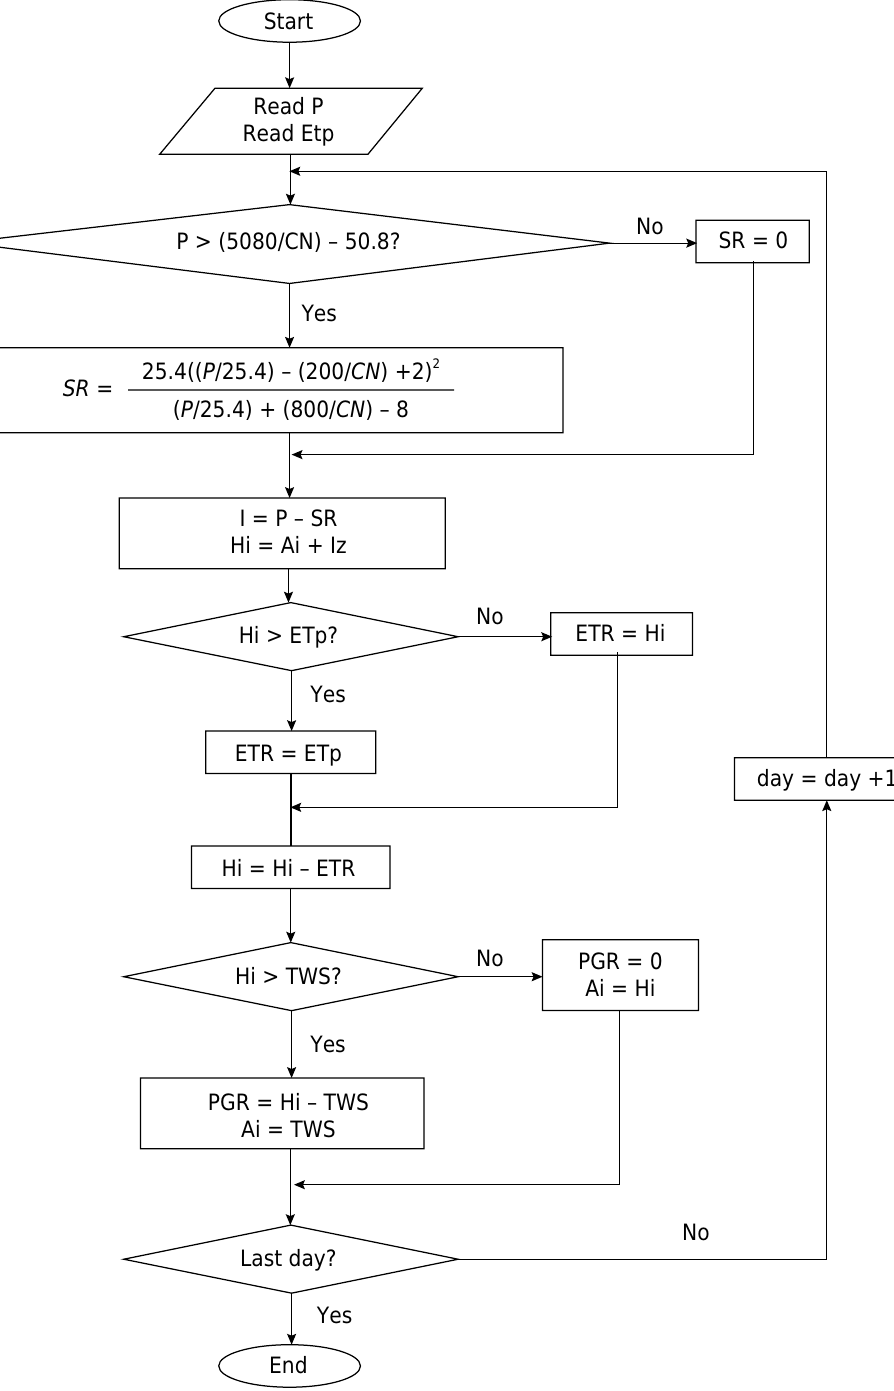
Figure 3. Schematic representation of the BALSEQ model (Modified from Lobo-Ferreira, 1981). P = rainfall (mm); ETp = potential evapotranspiration (mm); CN = coefficient of CN method; SR = surface runoff (mm); I = infiltration (mm); Hi = water content stored in the soil over the day (mm); Ai = water content stored in the soil at the end of the day (mm); ETR = actual evapotranspiration (mm); TWS = total soil water storage capacity (mm); PGR = potential groundwater recharge